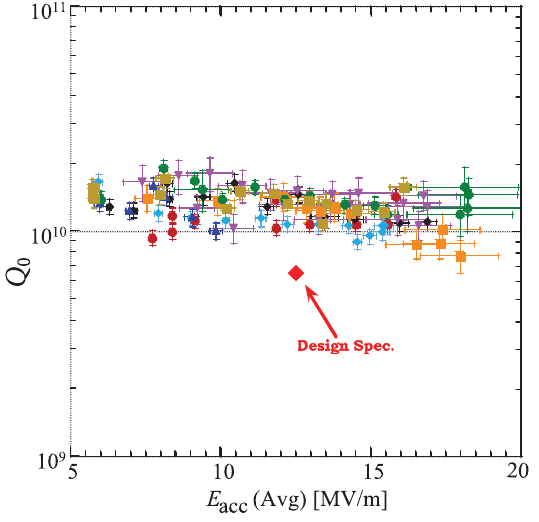
FIG. 24. Acceptance test performance of cavities in the first intermediate prototype upgrade cryomodule (SL21) in the CMTF (from